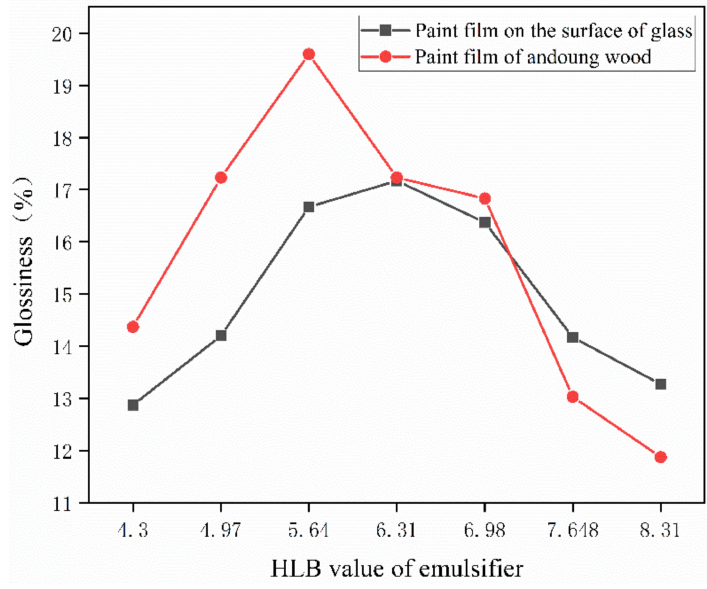
Figure 5. Effect of emulsifier HLB value on coating film glossiness.